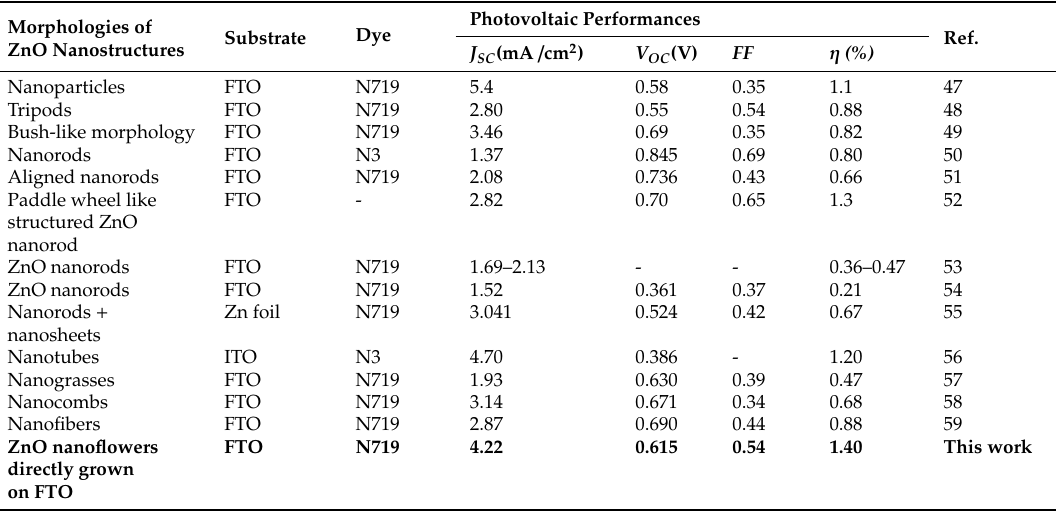
Table 1. Photovoltaic performance of fabricated DSSCs based on di ff erent ZnO nanostructure- based